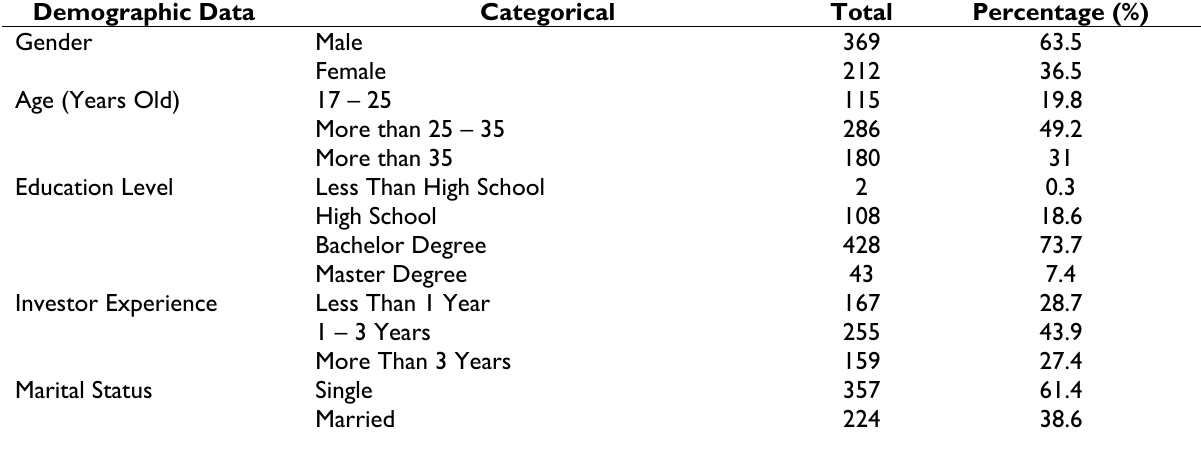
Table 1: The Demographic Data of Respondents Demographic